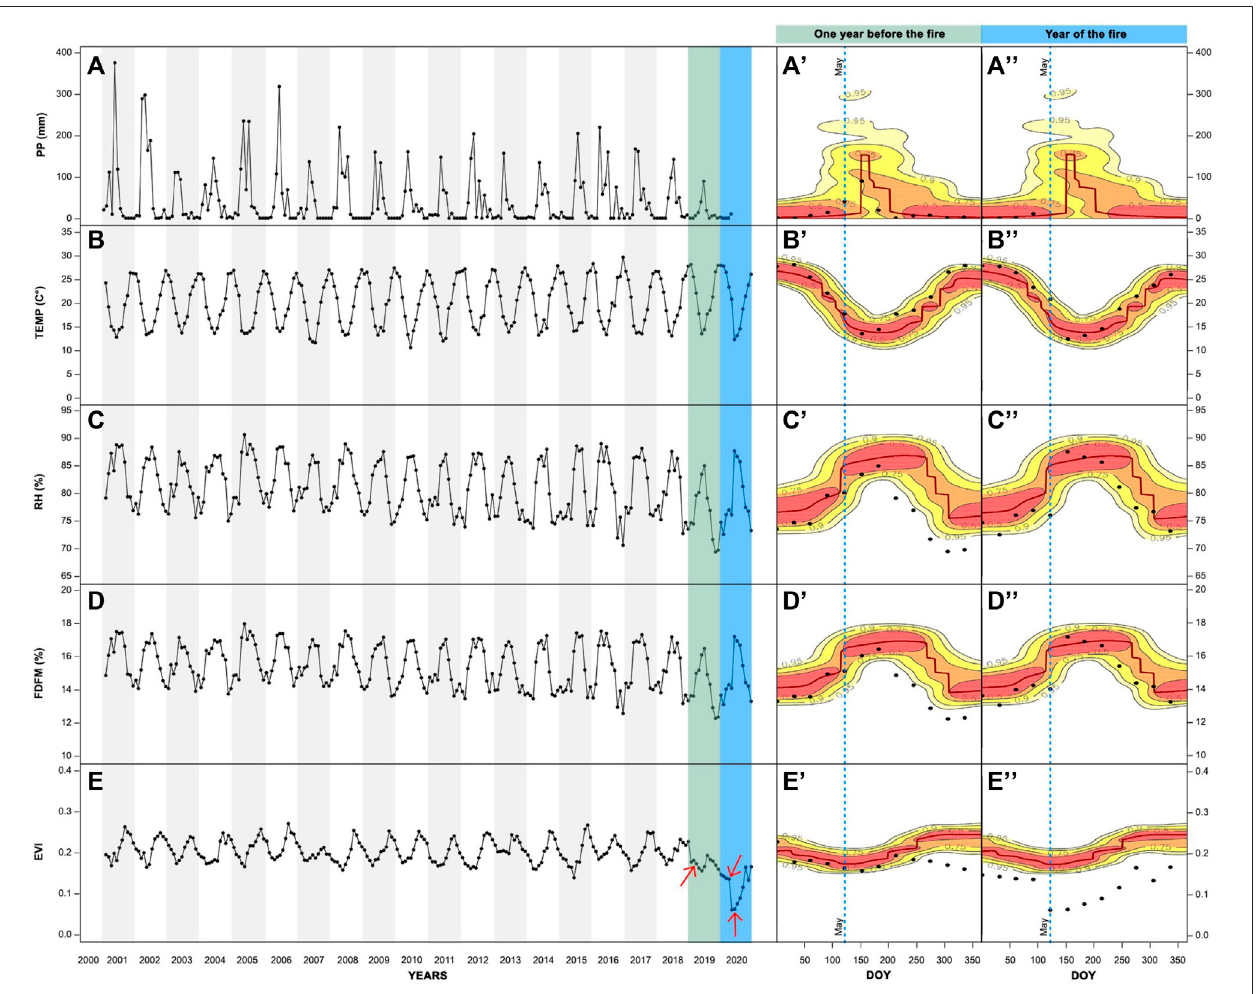
FIGURE 3 | Precursory drought conditions before the Colliguay wild fi re of May 2020. (A – E) From the top down, monthly time series of precipitation (PP), temperature (TEMP), relative air humidity (RH), fi ne and dead fuel moisture (FDFM) and Enhanced Vegetation Index (EVI) for the period 2000 – 2020. The green bar highlightstheyearpriortothe fi reevent(2019)whilethebluebarhighlightstheyearofthe fi re(2020).Theredarrowsshowspeci fi ctimesatwhichEVIanomalymapswere carried out and shown in Figure 4 . (A ’– E ’ ) and (A ’’– E ’’ ) show the annual reference frequency distribution (RFD) of the different variables and the values recorded during theyearpriortothe fi reeventandtheyearofthe fi reevent(black dots).Dotsoutsidethecoloredareasareobservationsoutsidethe0.95ofthehistoricalRFDand can be fl agged as an extreme negative condition of the given